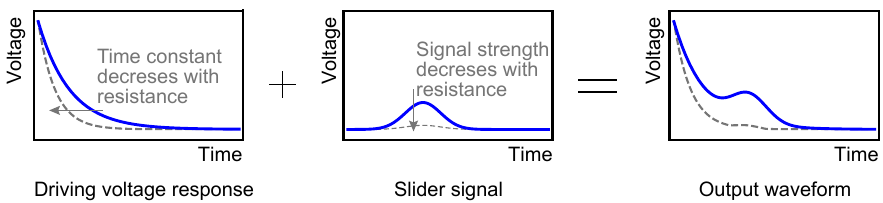
Figure 8. The output waveform consists of two components, the driving voltage response and the slider signal. The driving voltage response appears right after the voltage shift, whereas the slider signal reaches its peak when the slider speed reaches the maximum. Both components depend on the resistance of the sensing circuit. For example, when the resistance is decreased, the waveforms will change to gray dashed